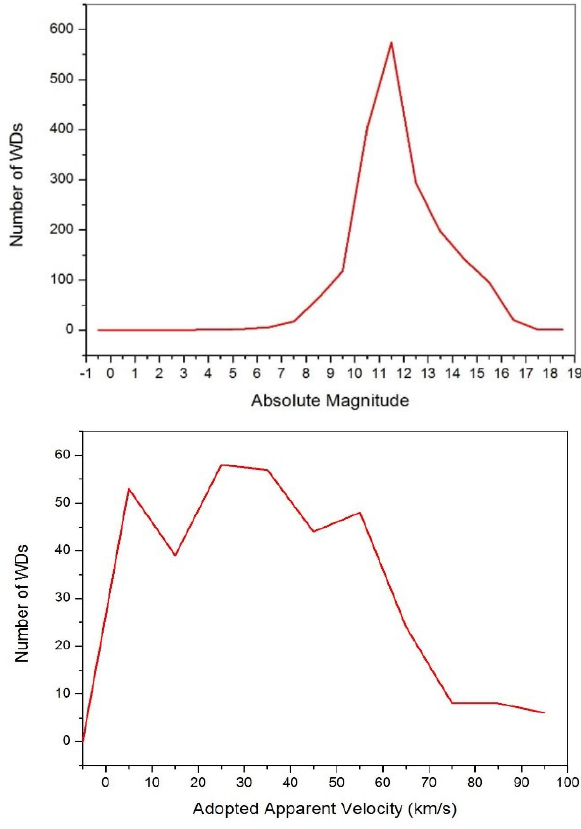
Figure 1. Distribution of absolute magnitudes and adopted apparent